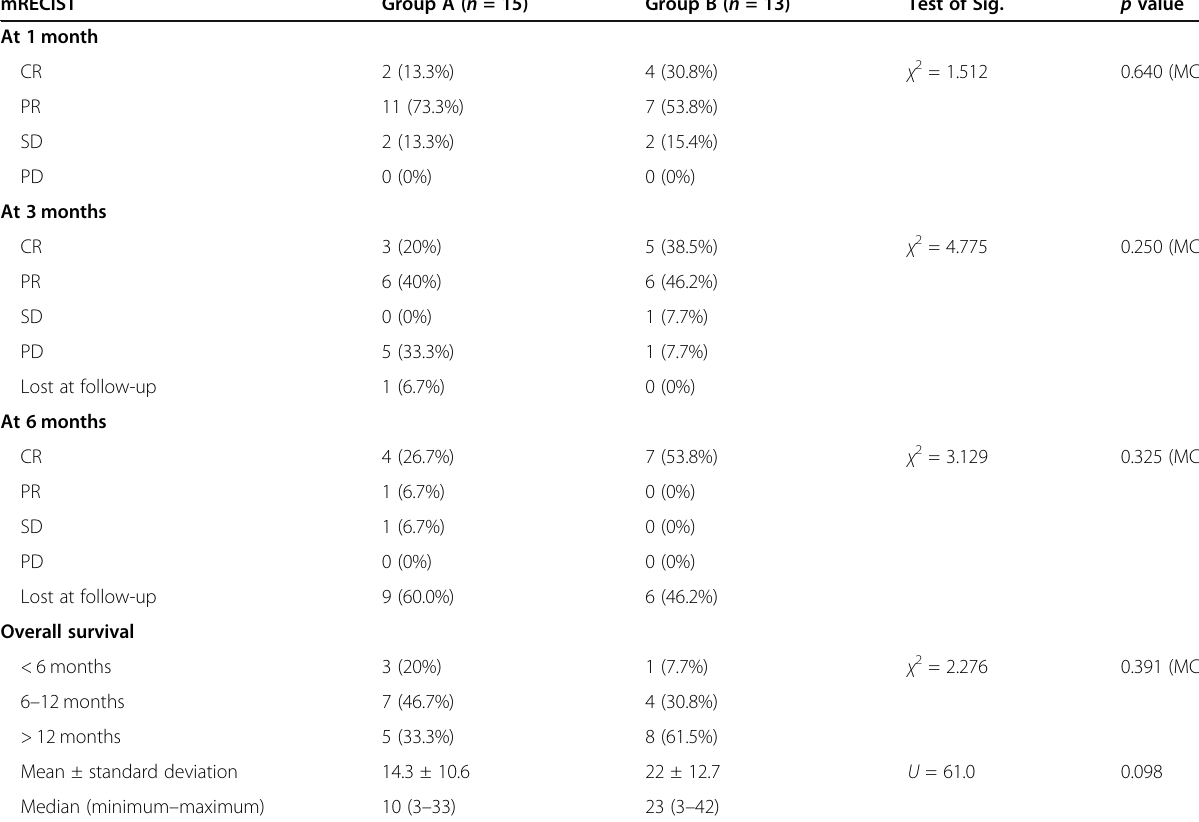
Table 3 Comparison between group A and group B according to mRECIST at follow-up mRECIST Group A ( n = 15) Group B ( n = 13) Test of Sig.